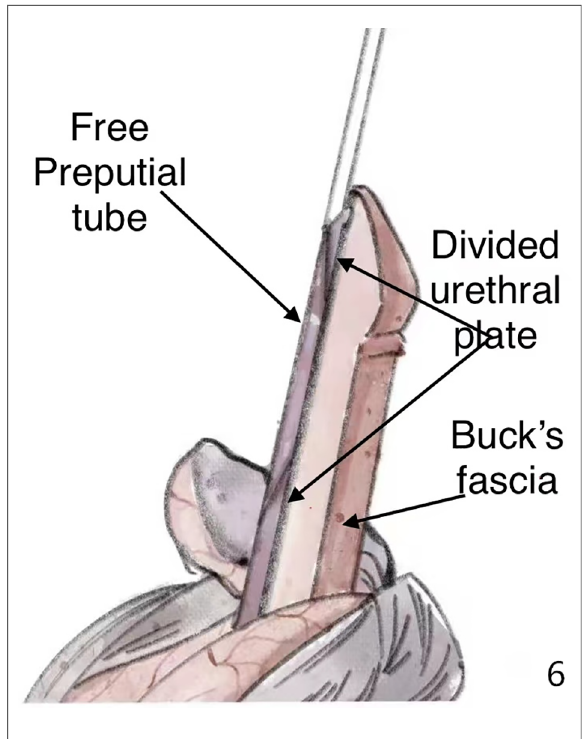
FIGURE 5 A fusiform fl ap which was longer than required was dissected on the dorsal prepuce.